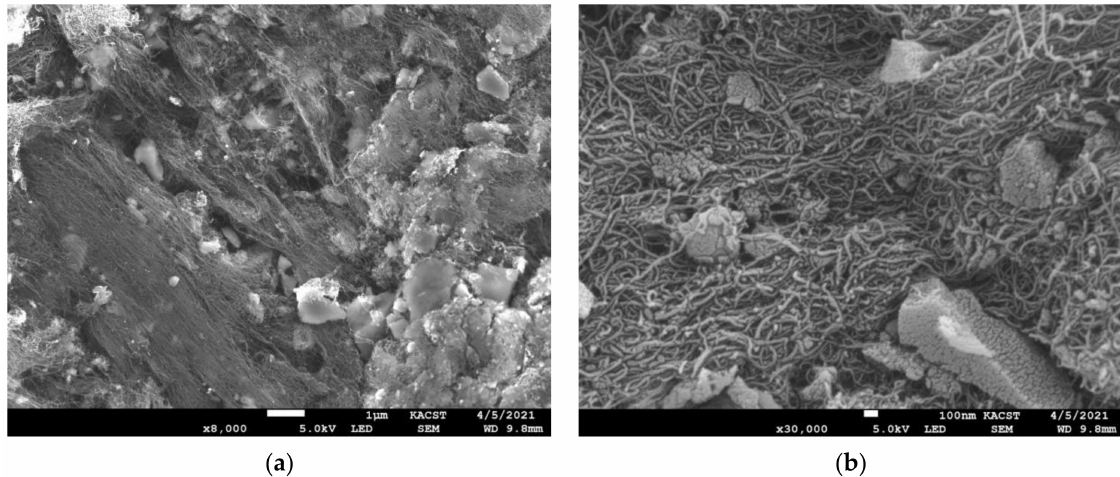
Figure 6. SEM images of 0.75 wt% MWCNT and silica gel composite at ( a ) 1 µ m and ( b ) 100 nm